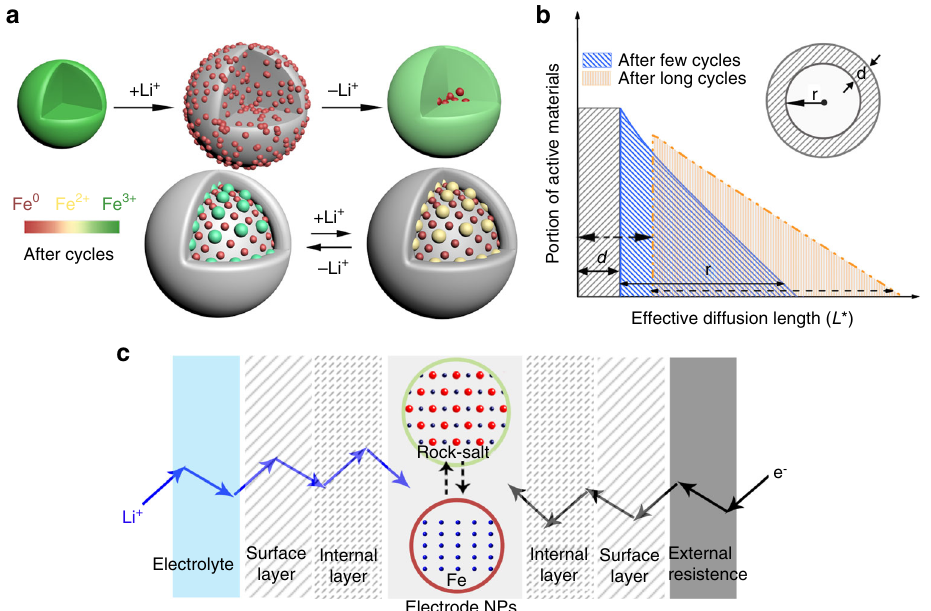
Fig. 6 Schematics of the lithiation behavior of conversion-type electrodes. a Schematic model depicts the phase evolution of Fe 3 O 4 electrode during cycling. b Schematic diagram showing the surface layers and effective diffusion length of charge pieces thicken over cycles. c Schematic of the effective diffusion paths of lithium ions and electrons to activate the electrochemical